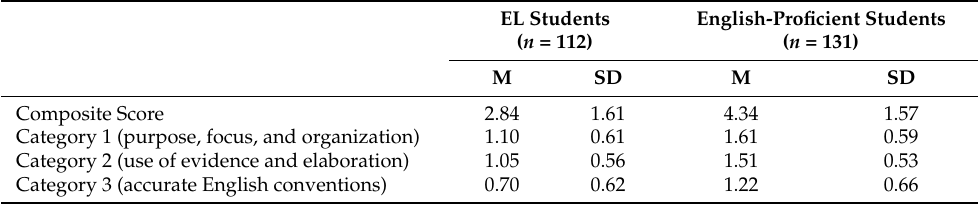
Table 5. Writing Quality Scores for ELs and English-Proficient Students.